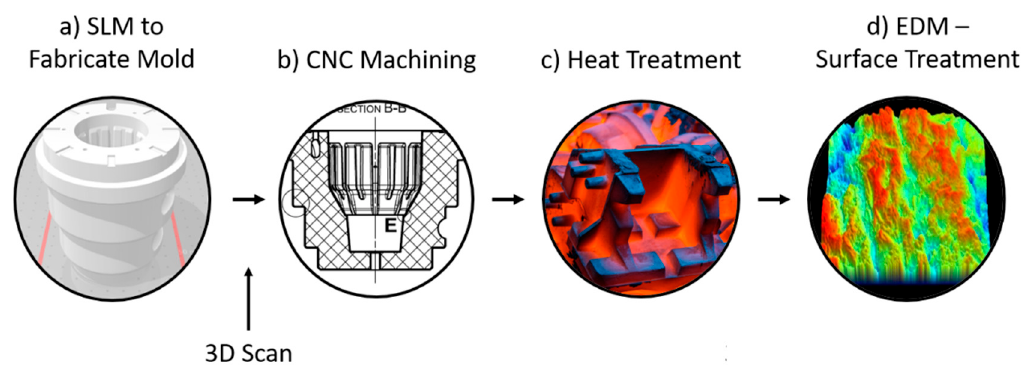
Figure 3. Manufacturing process chain operations for the mould insert: ( a ) 3D printing by laser-based powder-bed fusion (L-PBF), ( b ) CNC machining of outer contour, ( c ) heat treatment, ( d ) electron discharged machining (EDM) of the mould insert cavity.